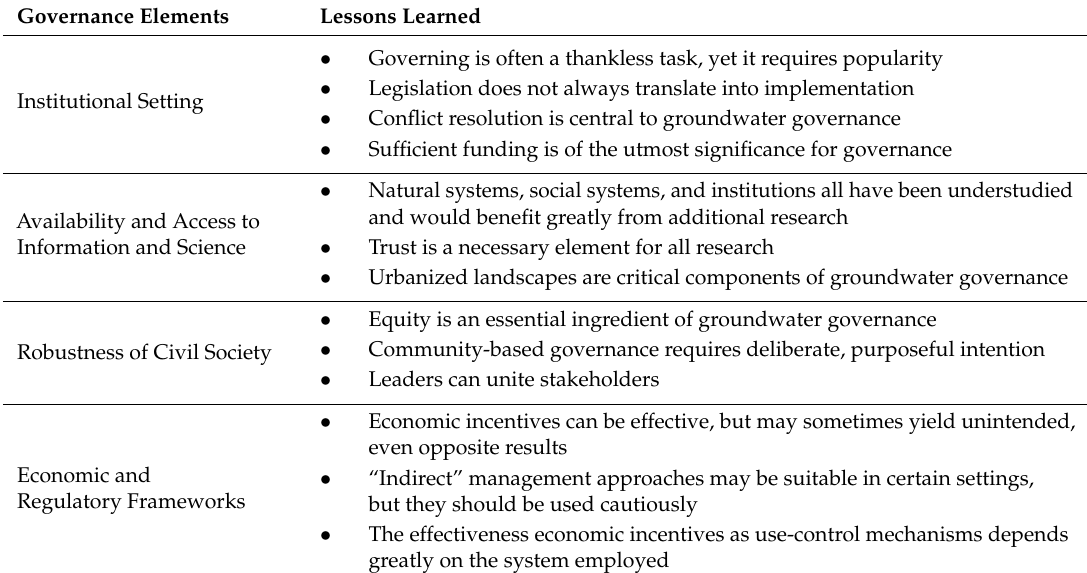
Table 2. Lessons learned from case studies across key governance